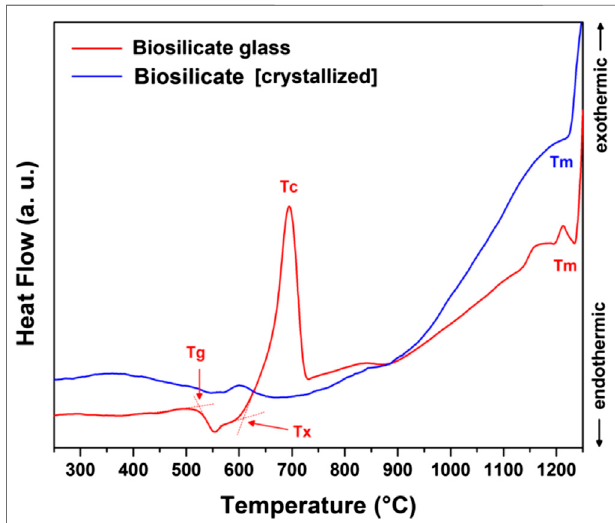
FIGURE 6 | DSC plots of as received Biosilicate ® powders and amorphous